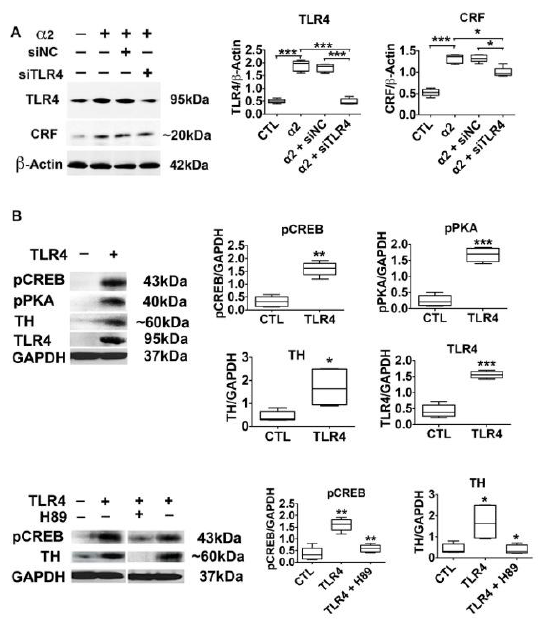
Figure 3. The α 2-activated TLR4 signal controls CRF and TH expression ( A ) Protein extracts from N2a cells mock- or α 2-transfected in the presence or absence of pHSVsiTLR4 or pHSVsiNC ( n = 5/group) were immunoblotted with antibodies to CRF, TLR4, or β -Actin, and the results are expressed as densitometric units normalized to β -Actin ± SEM. The levels of CRF and TLR4 are significantly higher in the α 2- than in the mock-transfected cells, and upregulation is inhibited by siTLR4 but not siNC (* p ≤ 0.05, *** p ≤ 0.001 by t -test). ( B ) Protein extracts from mock- or TLR4-transfected SK-N-SH cells ( n = 5 each) were immunoblotted with antibodies to pCREB, pPKA, TH, TLR4, or GAPDH, and the results are expressed as GAPDH-normalized densitometric units ± SEM. The levels of pCREB, pPKA and TH are significantly higher in the TLR4- than in the mock-transfected cells. The pCREB and TH upregulation is inhibited by treatment with the PKA-specific inhibitor H89 (10 µ M) (* p < 0.05; ** p < 0.01; *** p < 0.001 by t -test).